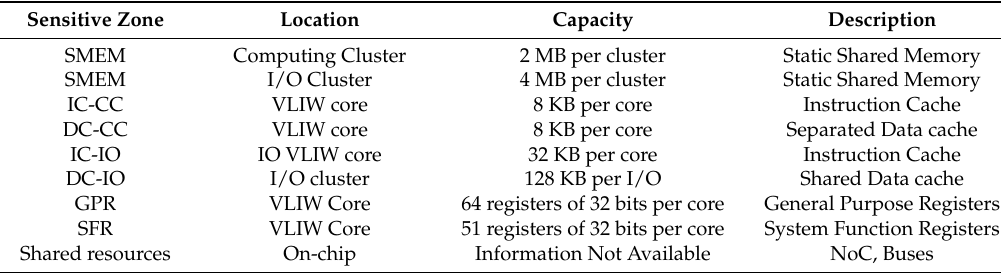
Table 1. Sensitive zones of the MPPA-256 many-core